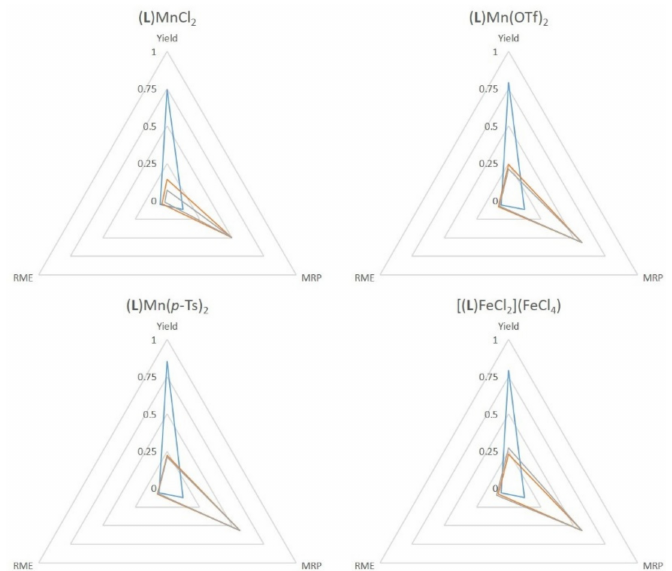
Figure 21. Comparison of green metrics for the oxidation of cyclohexanol (yield, RME and MRP) with the different catalysts and the different co-reagents acetic acid (blue), SiO 2 @COOH (E) (orange) and SiO 2 @COOH (M)